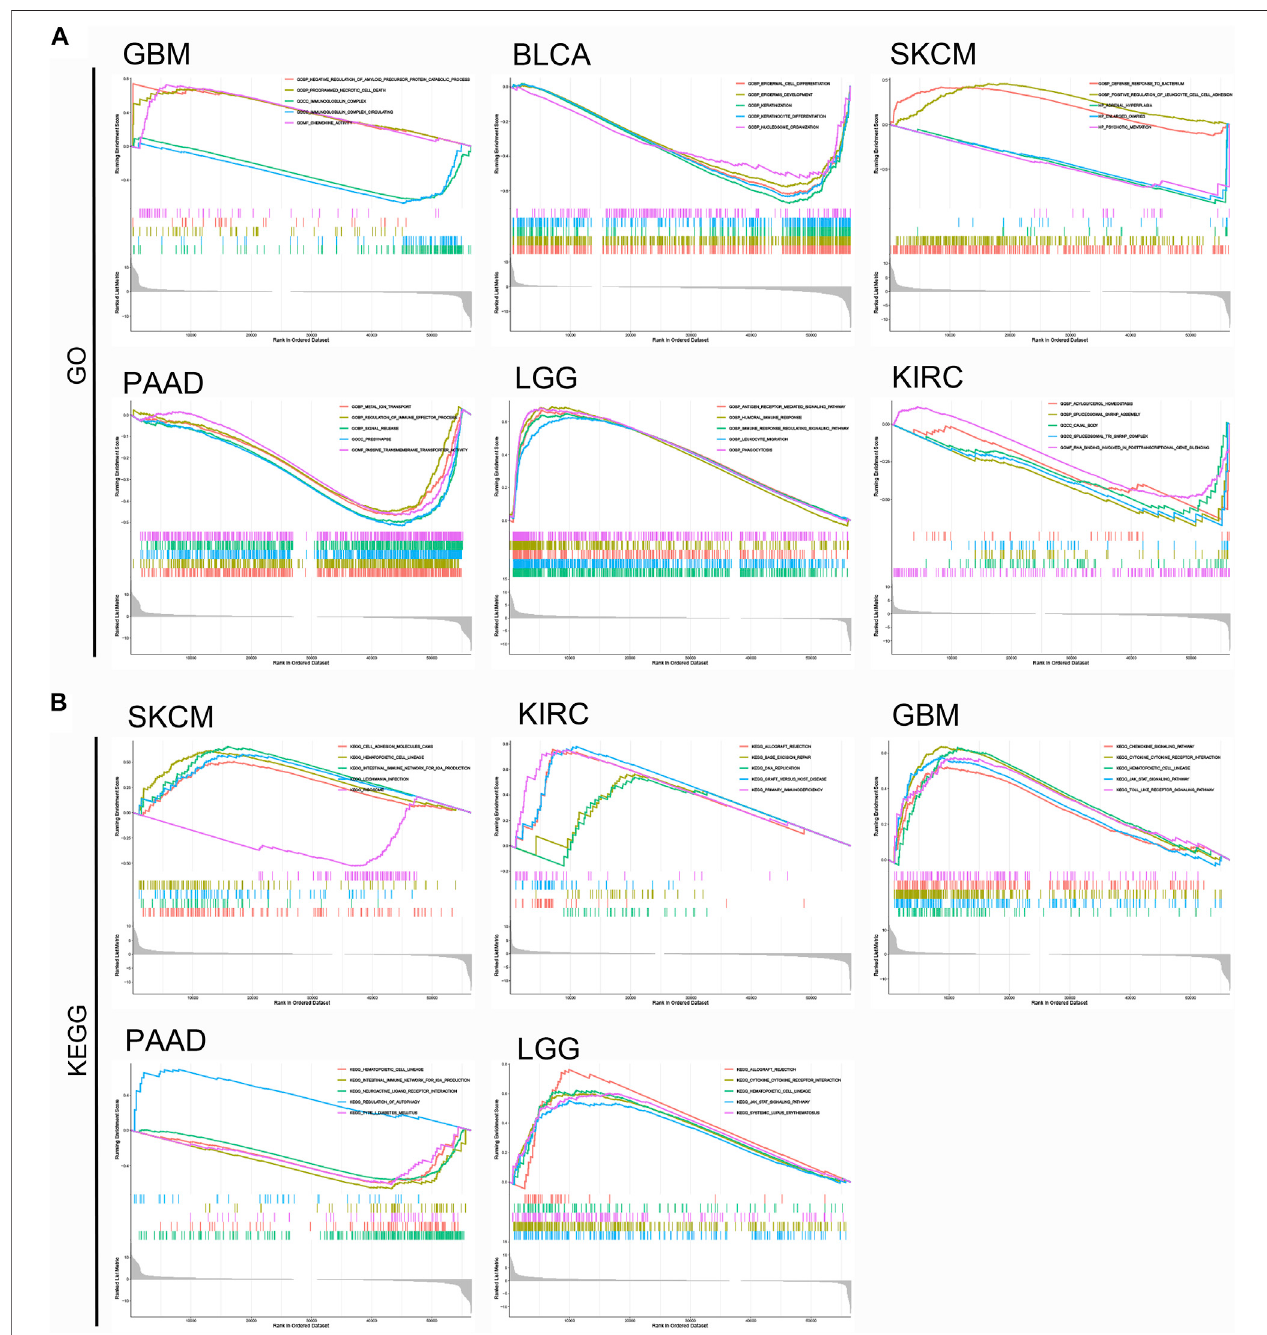
FIGURE 11 | GSEA analysis of top functional terms associated with KCNN4 expression. (A) GO functional terms of KCNN4 in various cancer types in the increased-risk group and decreased-risk group. (B) KEGG pathway analysis of KCNN4 in various cancer types in the increased-risk group and decreased-risk group.